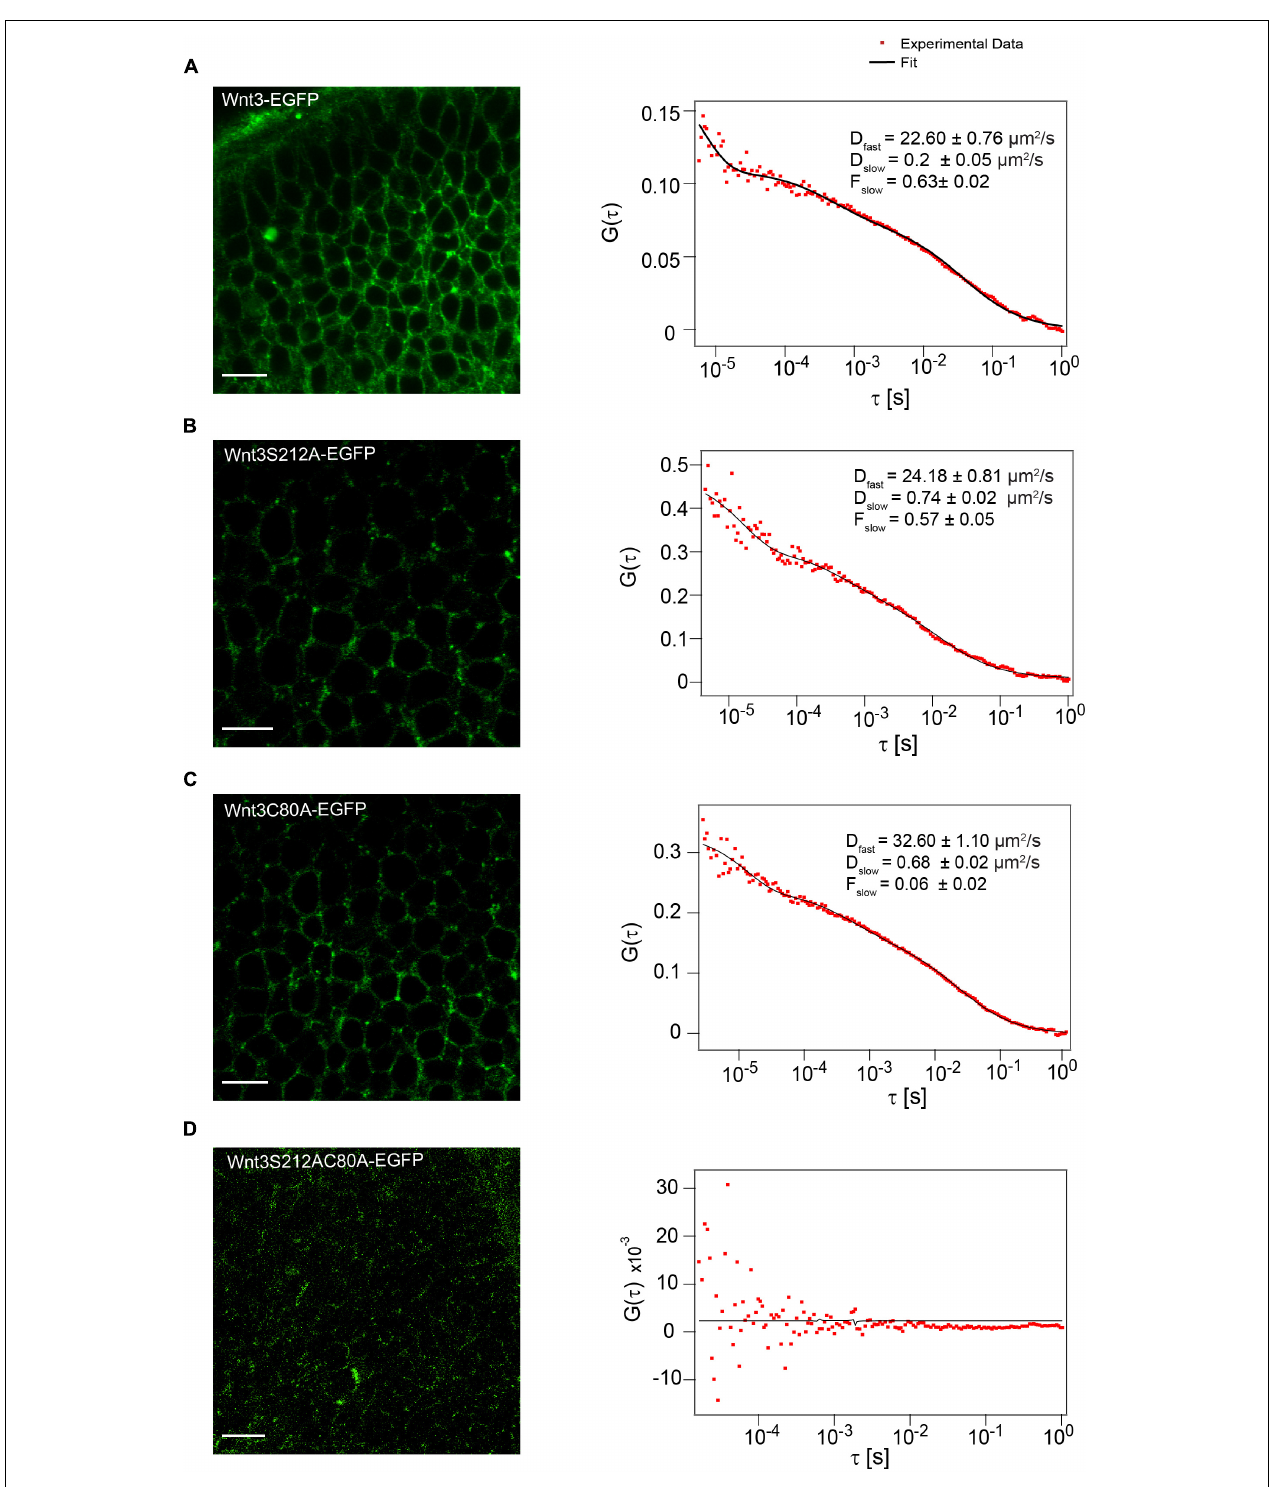
FIGURE 4 | Influence of C80 and S212 lipidation on membrane localization in vivo . (A) Expression of Wnt3-EGFP on the cell membrane (left) and a representative autocorrelation function (ACF; dots) and fit (line) of a Wnt3-EGFP FCS measurement at a cell membrane (right). (B) Expression of Wnt3S212A-EGFP on the cell membrane (left) and a representative autocorrelation function (ACF; dots) and fit (line) of a Wnt3S212A-EGFP FCS measurement at a cell boundary (right). (C) Expression of Wnt3C80-EGFP on the cell membrane (left) and a representative autocorrelation function (ACF; dots) and fit (line) of a Wnt3C80A-EGFP FCS measurement at a cell membrane (right). (D) Expression of Wnt3S212AC80-EGFP on the cell membrane (left) (Image brightness was increased for clear visualization) and a representative autocorrelation function (ACF; dots) and fit (line) of a Wnt3S212AC80A-EGFP FCS measurement at a cell membrane (right). The FCS curves were fitted using 2D-2particle-1triplet model. BV, fourth brain ventricle; Ce, cerebellum; OT, optic tectum. Orientation: anterior to the left. Scale bar 10 µ m.